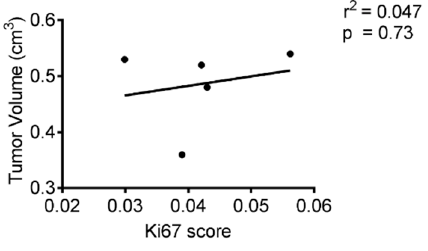
Figure 2. Comparison between tumor volume and Ki67 score.